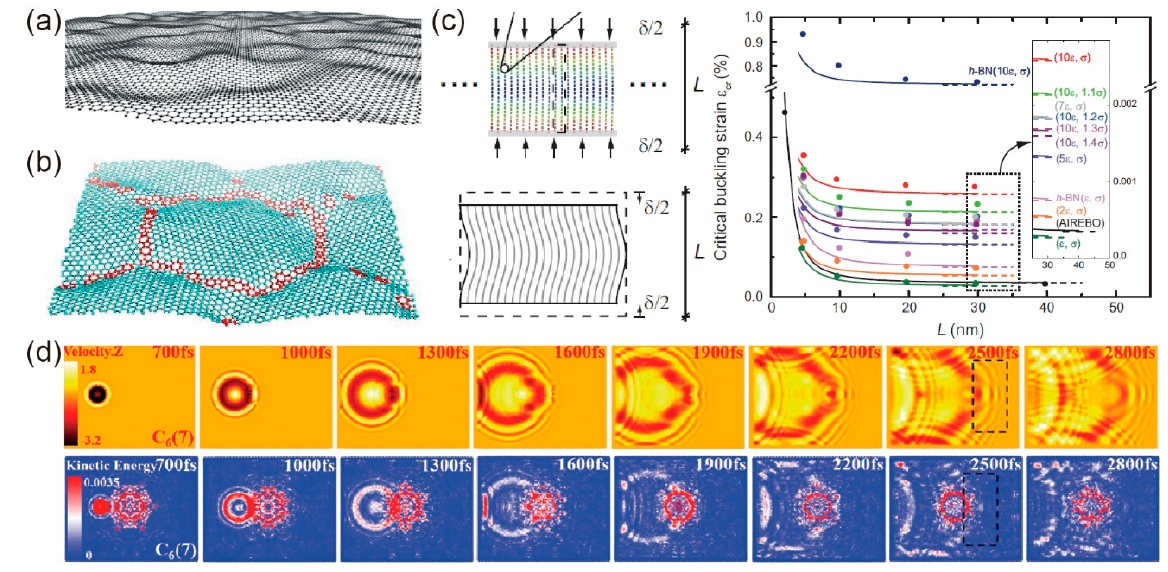
Figure 5. Out ‐ of ‐ plane deformation of GLMs. ( a ) Intrinsic rippling. Reprinted with permission from [14]. ( b ) Buckling induced by grain boundaries. Reprinted with permission from [69]. ( c ) Intrinsic buckling of GLNs induced by external load parallel to the sheet direction. Reprinted with permission from [33]. ( d ) Wrinkle propagation through flower ‐ like GBs. Reprinted with permission from [86].